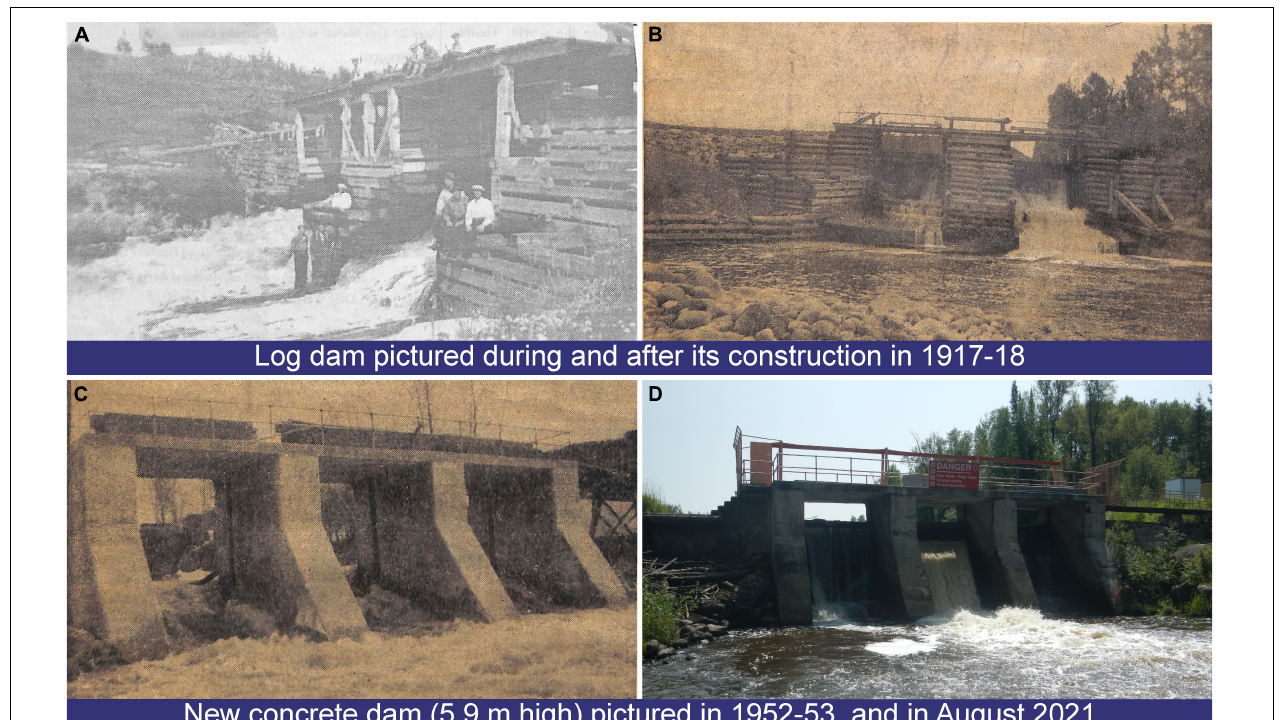
FIGURE 2 | The old and the new on Driftwood River at Monteith. First log dam (A,B) and second concrete dam (C) in the years of their construction as compared to today structure (D) . Historical photos (B,C) by Mrs. C. Clifford were published in an unknown local newspaper on May 6, 1953. All historical photos retrieved from the digitalized archives of the Monteith Women Institute Tweedsmuir Community History, a courtesy of the Federated Women’s Institutes of Ontario (FWIO; https://collections.fwio.on.ca). Photo in August 2021 by